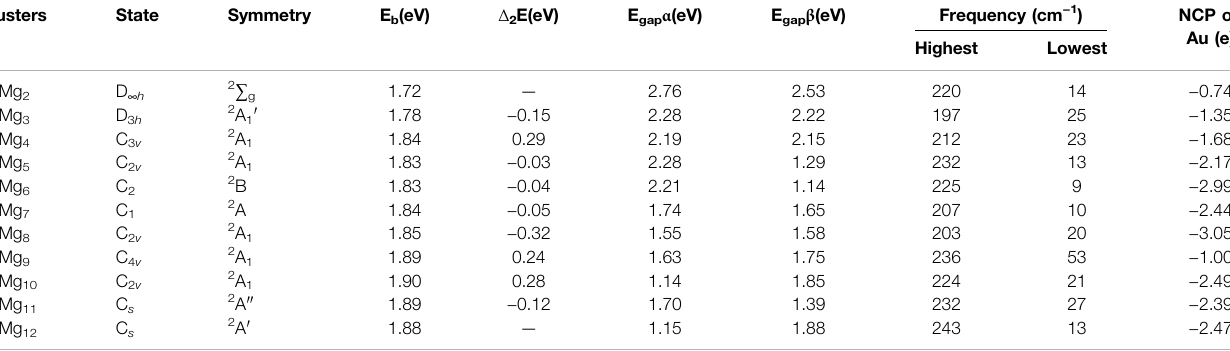
TABLE 1 | State, symmetry, Eb, Δ 2 E, Egap for α - and β -electrons, frequency and NCP on Au atom in the ground state of AuMg n ( n = 2 – 12) nanoclusters.